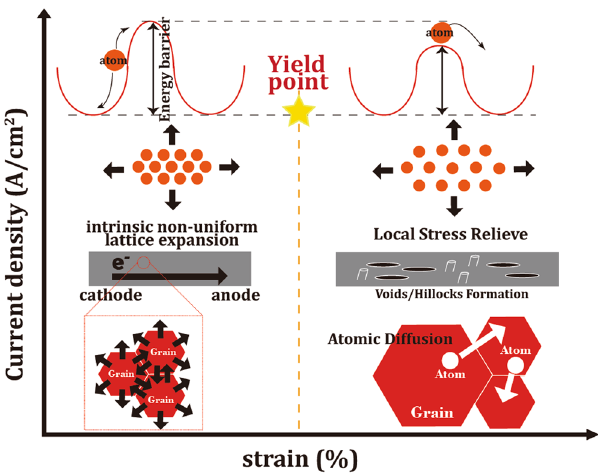
Figure 7. The schematic diagram of the universal EM mechanism proposed in this